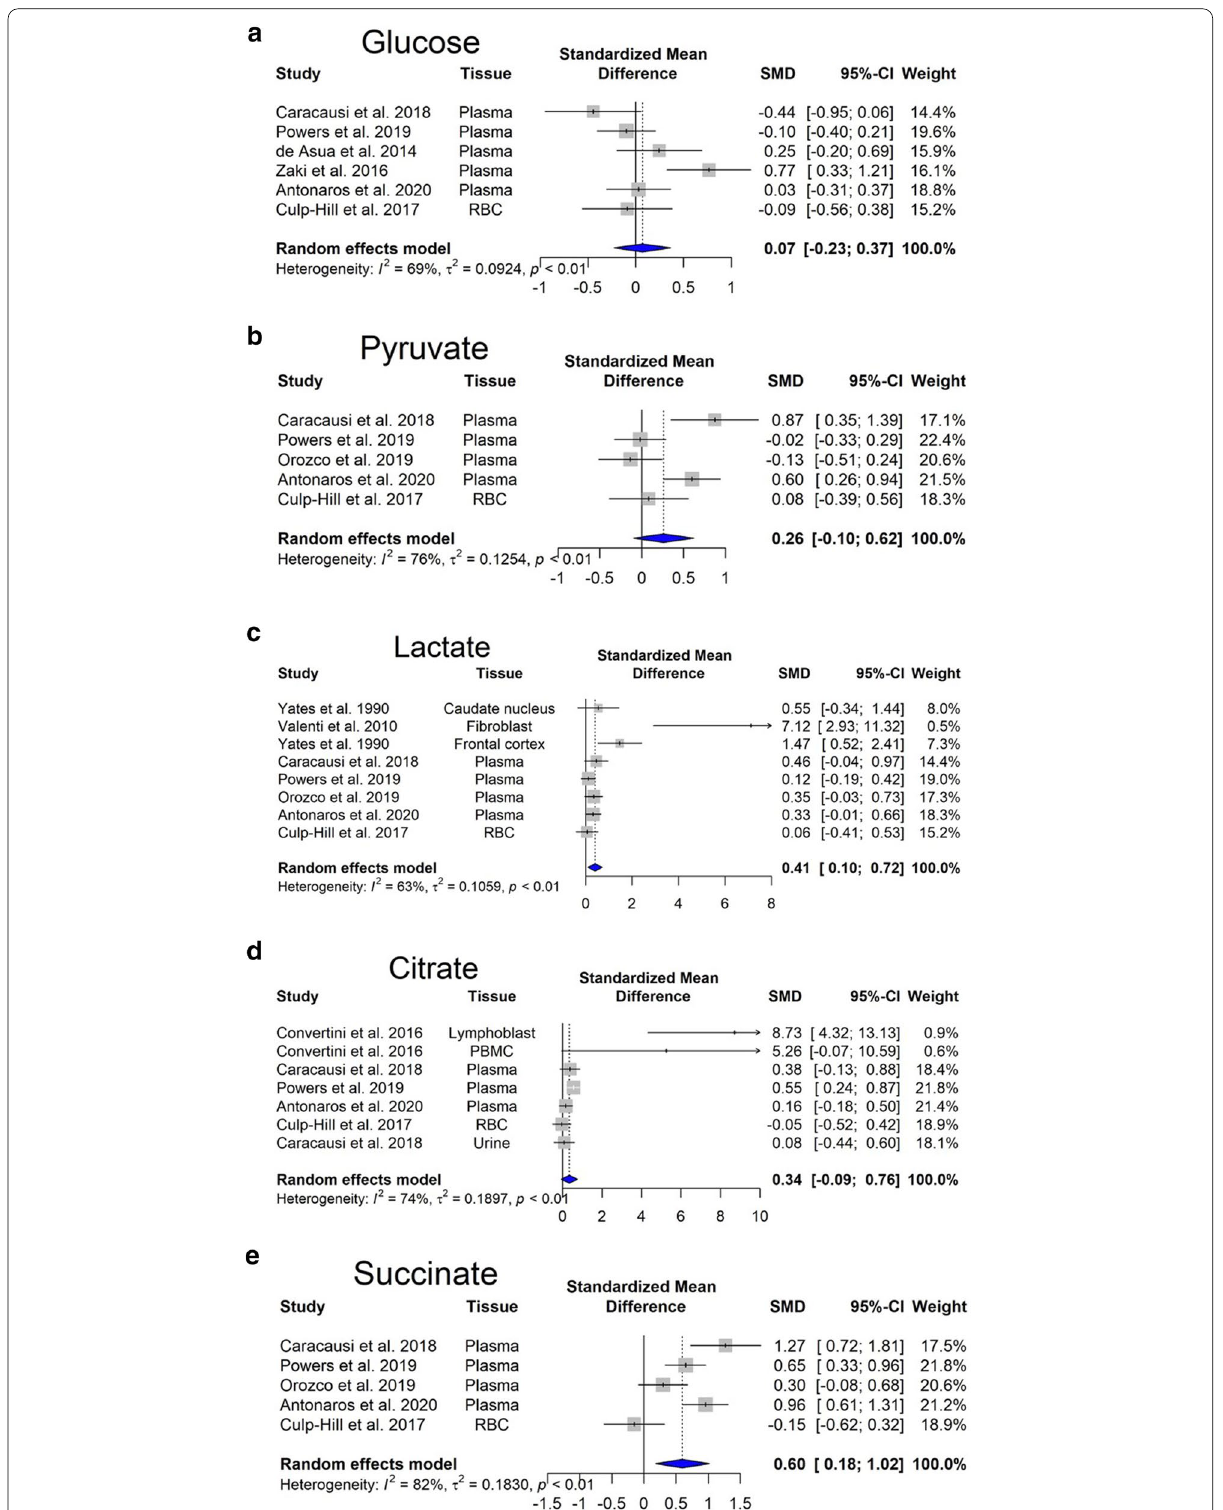
Fig. 4 Changes in Krebs cycle-related analytes in Down syndrome. Forest plot showing relative weights, standardized mean difference (Hedges’ g) with confidence intervals. Overall average effect size is displayed by filled